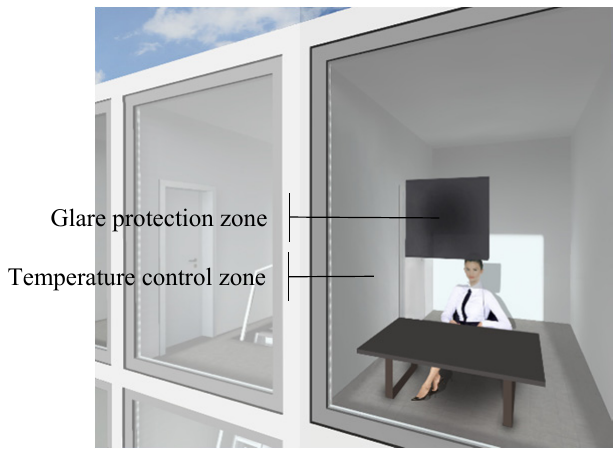
Fig. 4 Substructuring of the glazing area in separately controlled zones. Rendering: V. Kalaydzhieva, ILEK (Kalaydzhieva 2015) The transmittance of the glare protection zone is controlled in order to prevent direct glare. Within numerical simulations the Daylight Glare Probability factor (DGP) according to Wienold and Christoffersen (Wienold and Christoffersen 2006) was used to detect the glare effect. The developers of the DGP formula defined a DGP value higher than 0.42 as a high probability for presence of a disturbing glare effect and DGP higher than 0.53 – for an intolerable glare effect, according to user assessments (Wienold 2009). Hence, if a glare effect is detected within the simulation, the transmittance of the glare protection zone is stepwise reduced till the DGP value is below 0.4. The authors used ten switching steps between the maximally dark and maximally transparent state of the glazing, what is considered a good compromise between simulation efforts and the continuous switching ability of the